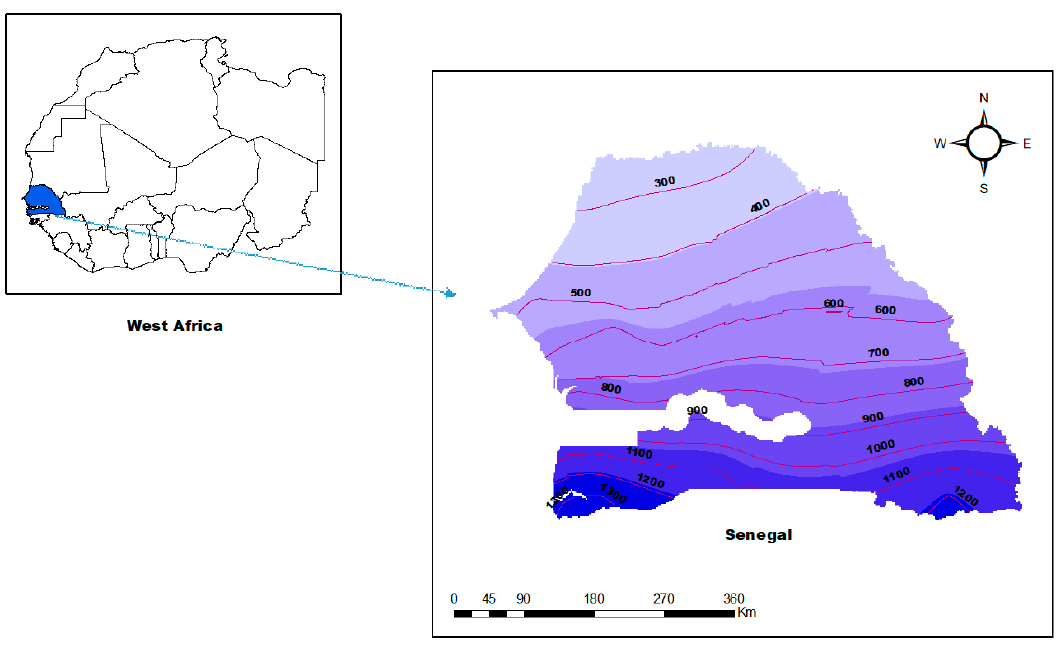
Figure 1. Senegal country (blue) in West Africa. Red lines are isohyets and numbers are their corresponding values in mm.